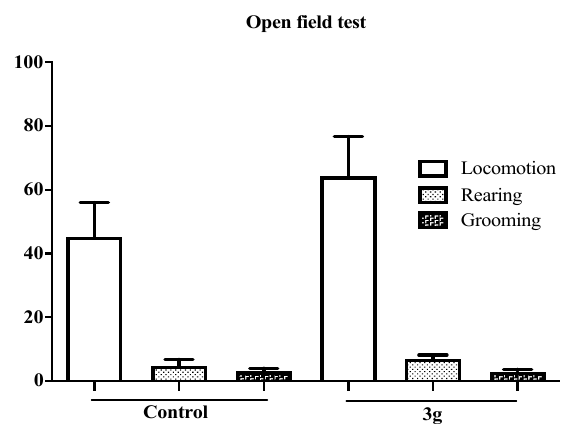
Figure 5. Effects of single treatment with 3g (50 mg/kg) on the exploratory behaviors in the open-field test. Locomotion indicates the number of line crossings; rearing indicates the number of times seen standing on hind legs; grooming indicates the number of modifications. Ten animals were used for each group.